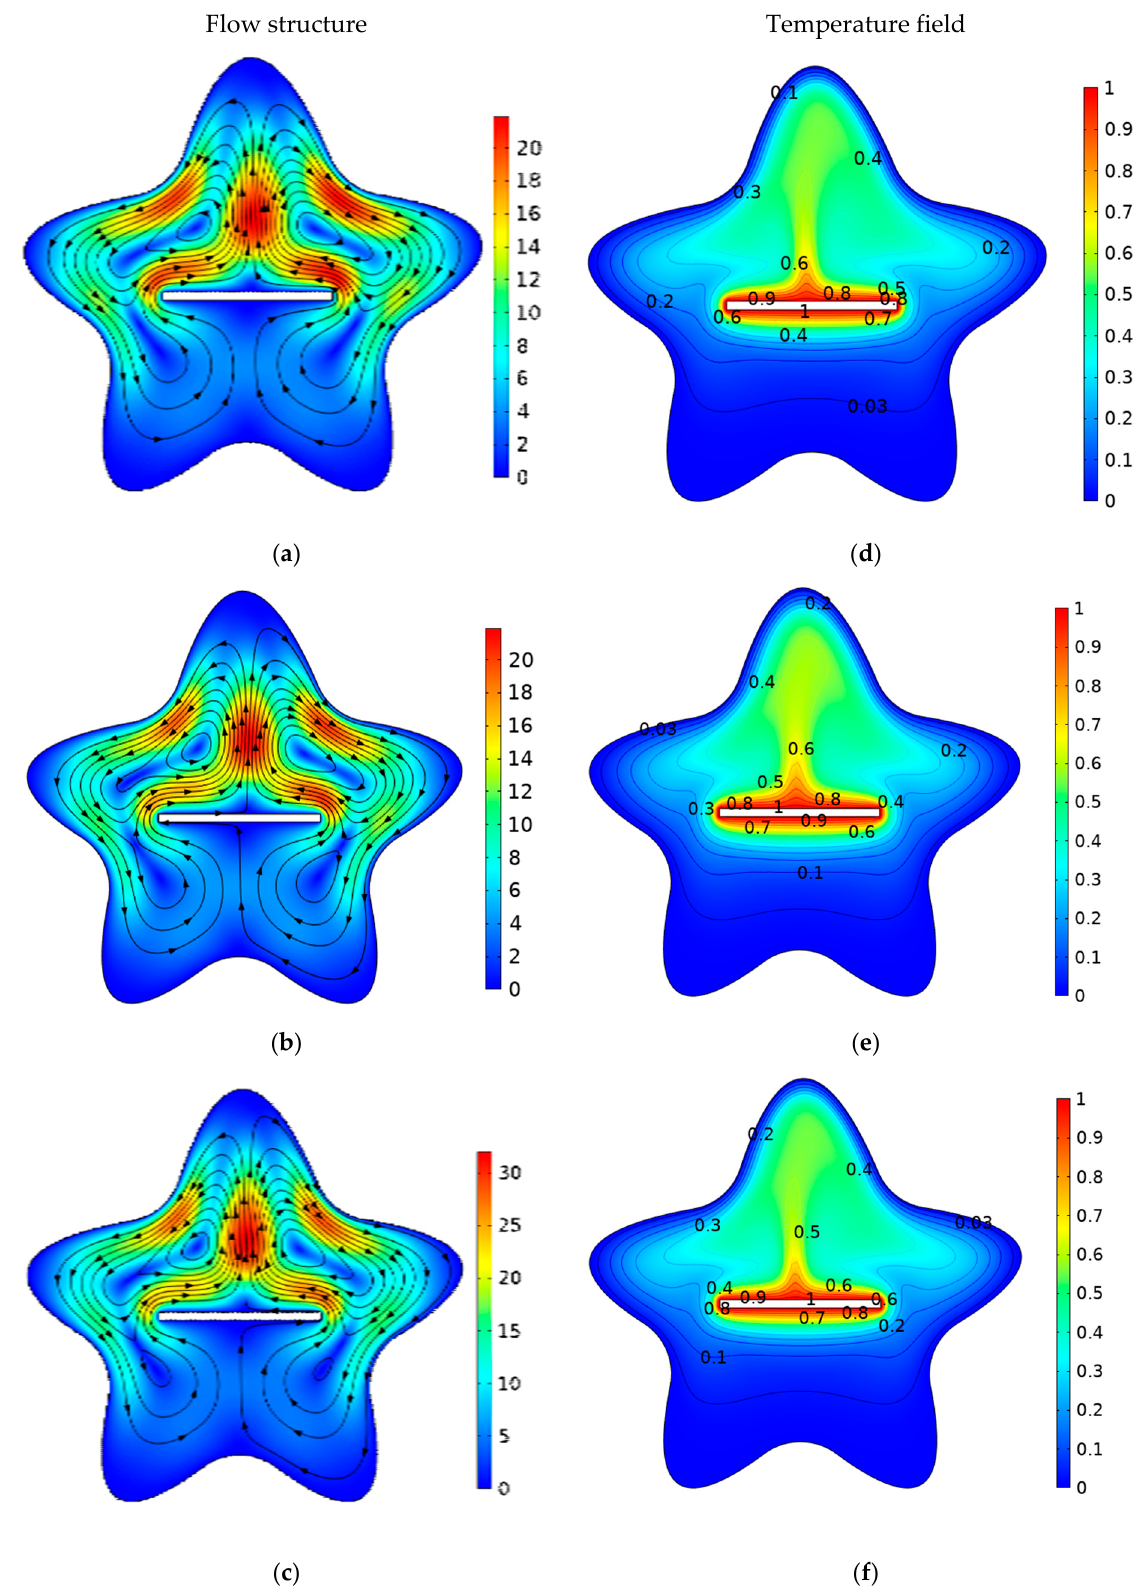
Figure 6. Flow structures ( a – c ) and temperature fields ( d – f ) for Ra = 10 5 , Ha = 25, and various volume fraction values. ( a ) φ = 0.01; ( b ) φ = 0.02; ( c ) φ = 0.04; ( d ) φ = 0.0; ( e ) φ = 0.02; ( f ) φ = 0.04.